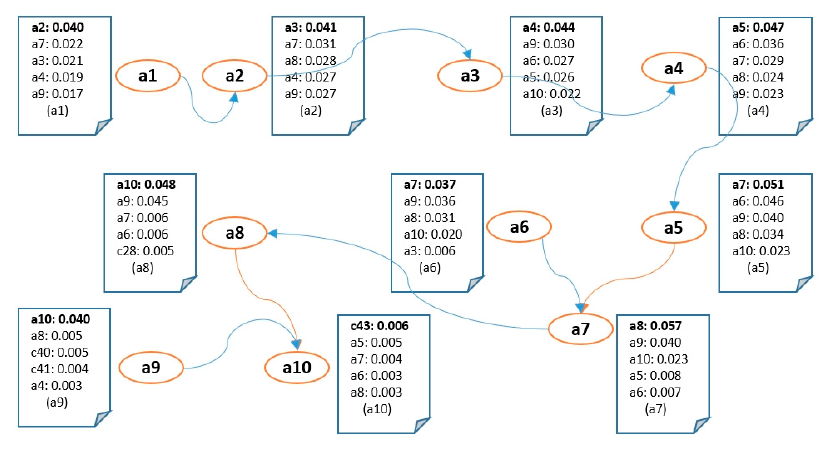
Figure 11. The dynamic correlation graph based on the analysis results.